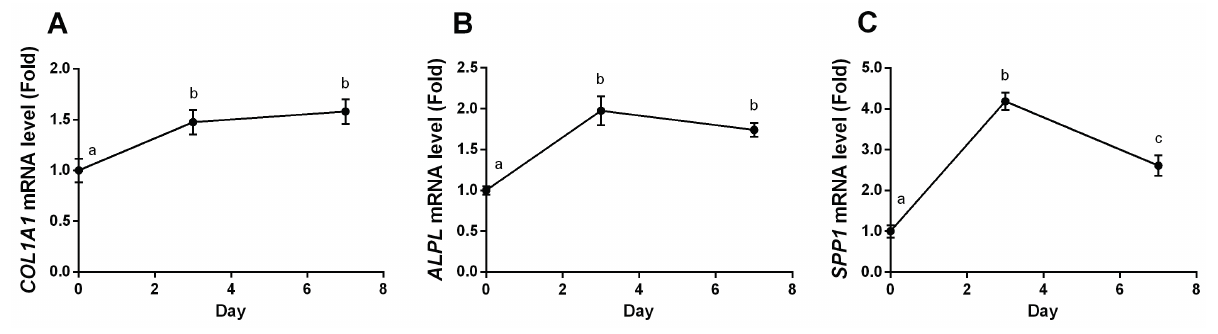
Figure 7. Effects of long term YPEP treatment on osteogenic gene expressions. ( A ) Collagen, type I, alpha 1 ( COL1A1 ); ( B ) Alkaline phosphatase ( ALPL ); ( C ) Secreted phosphoprotein 1 ( SPP1 , osteopontin). All data are expressed as mean ± SD of the three cultures. Values not sharing a common alphabet as superscripts are significantly different from each other at the level of p <